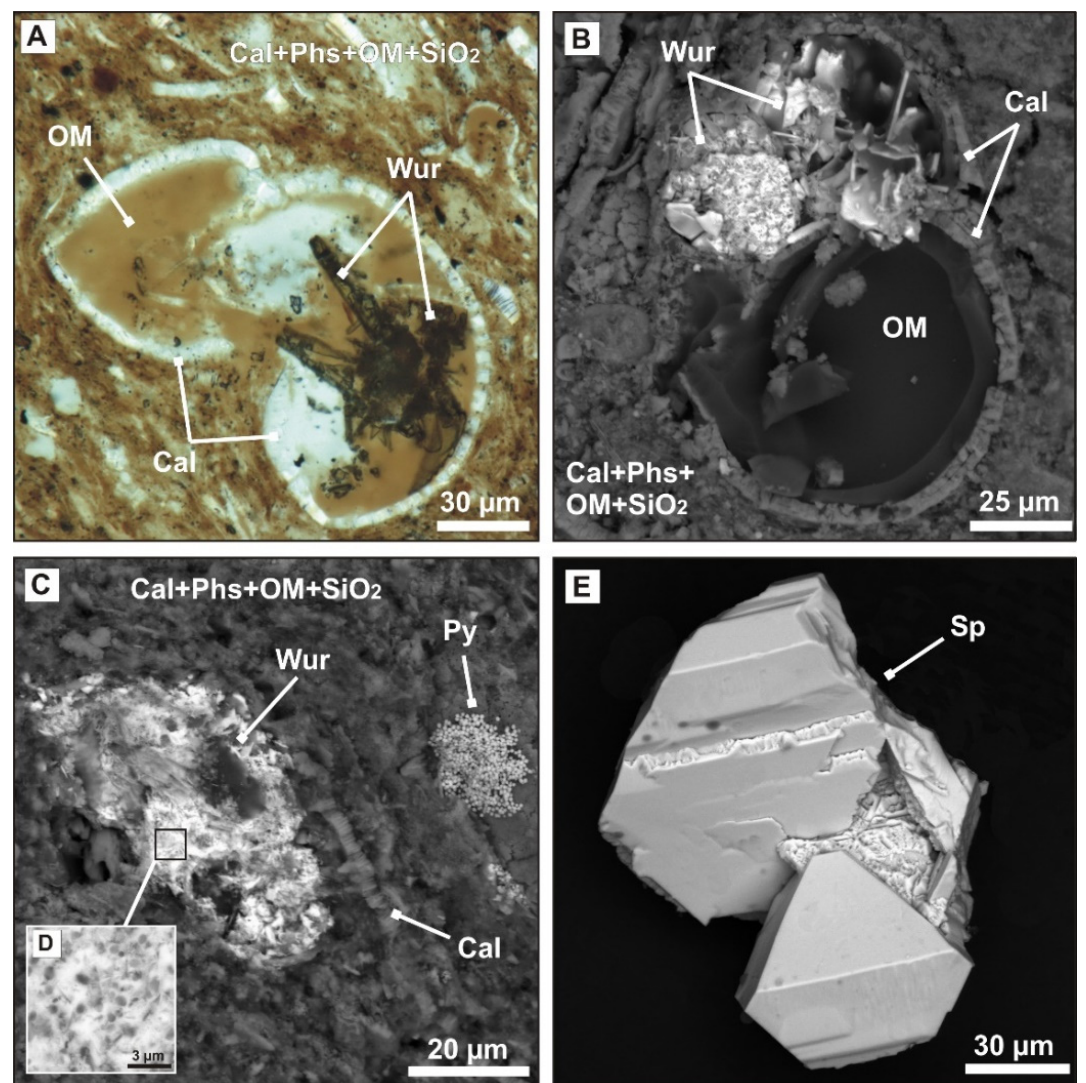
Figure 4. Cd-würtzite, Cd-sphalerite, and associated minerals in bituminous phosphatic chalk (‘oil-shale’) of the lower Muwaqqar Chalk Marl Formation. ( A ) Platy Cd-rich würtzites clustered inside foraminiferal chambers in a biomicritic matrix composed of calcite, silica, disseminated organic matter, and pristine phosphorite. ( B ) Foraminifera chambers filled with S-rich solid organic matter (type-II kerogen). Cd-rich würtzites occur as platy crystals and microcrystals inside chambers. ( C ) Cd-rich würtzite microcrystals and framboidal pyrite in biomicritic matrix. ( D ) Micrometer platy Cd-rich würtzite crystallites intimately intergrown with diatom frustules and radiolaria spicules (opal-CT). ( E ) Simple twinned pseudooctahedral sphalerite. Optical images in plane-polarized light ( A ) and BSE images ( B – E ). Cal = calcite, OM = organic matter, Phs = phosphorite, Py = pyrite; Sp = sphalerite, Wur = wurtzite. Table 2. Average composition of sphalerite and würtzite from sedimentary rocks (‘oil shales’) of the Muwaqqar Chalk Marl Formation (SEM-EDS and EPMA data, wt%).